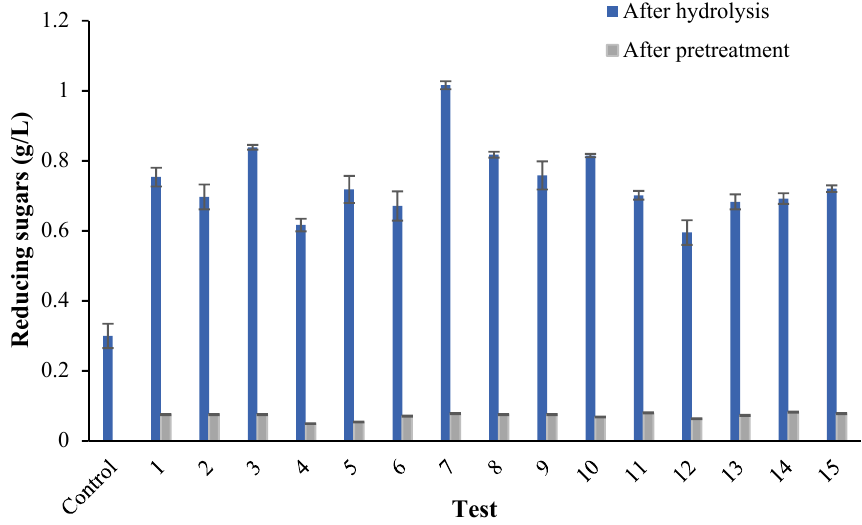
Figure 1. Reducing sugars after microwave pretreatment and after acid hydrolysis.